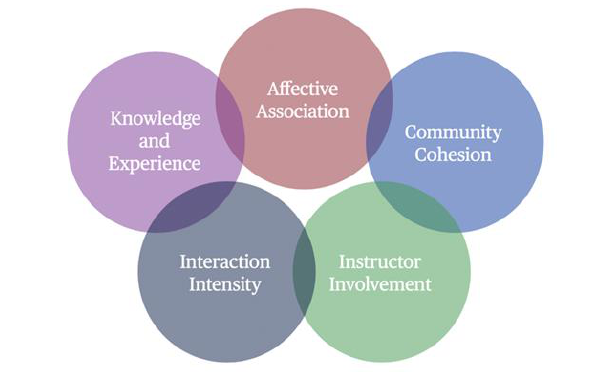
Figure 2: Elements of Social Presence (Institute of Education Sciences,